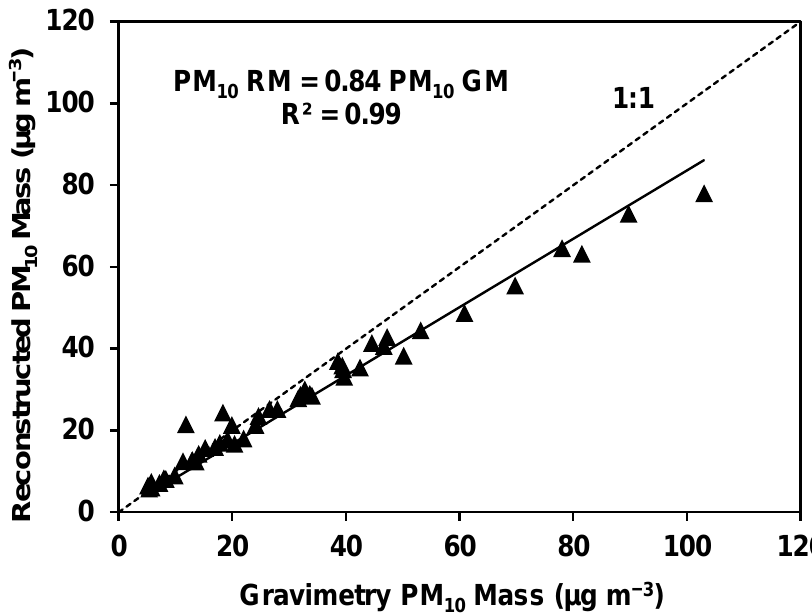
Figure 9. Correlation between reconstructed and gravimetric PM 10 mass concentrations.